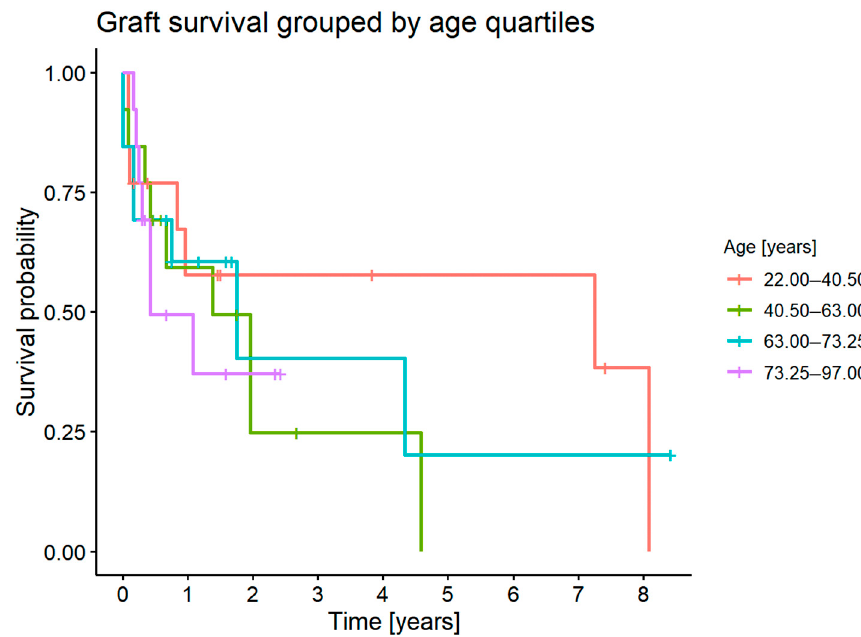
Figure 10. Graft survival grouped by age quartiles.